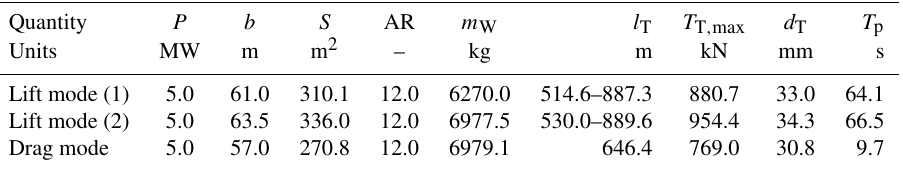
Table 4. Wing and tether characteristics of the reference trajectories optimised for lift- and drag-mode AWE systems at rated wind speed U D = 12ms − 1 under consideration of offshore